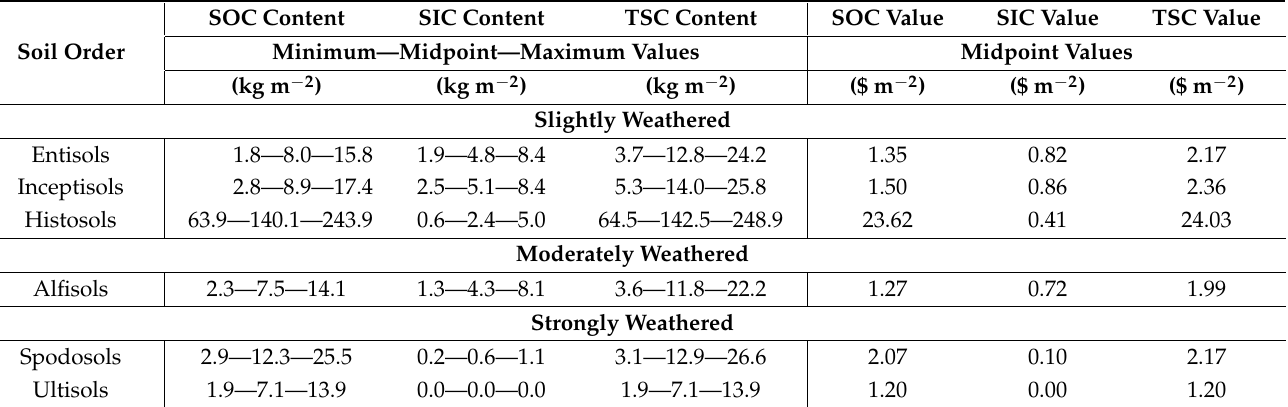
Table 4. Area-normalized values ($ m − 2 ) and carbon (C) content (kg m − 2 ) of soil organic C (SOC), soil inorganic C (SIC), and total soil C (TSC = SOC + SIC) using values provided by Guo et al. (2006) [15] for the upper 2-m of soil and using an avoided social cost of carbon (SC-CO 2 ) value of $46 per CO 2 metric ton, applicable until 2025 (2007 U.S. dollars, with an average discount rate of 3%